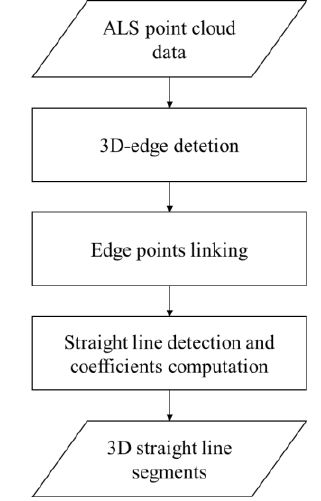
Figure 3. 3D straight line segment extraction